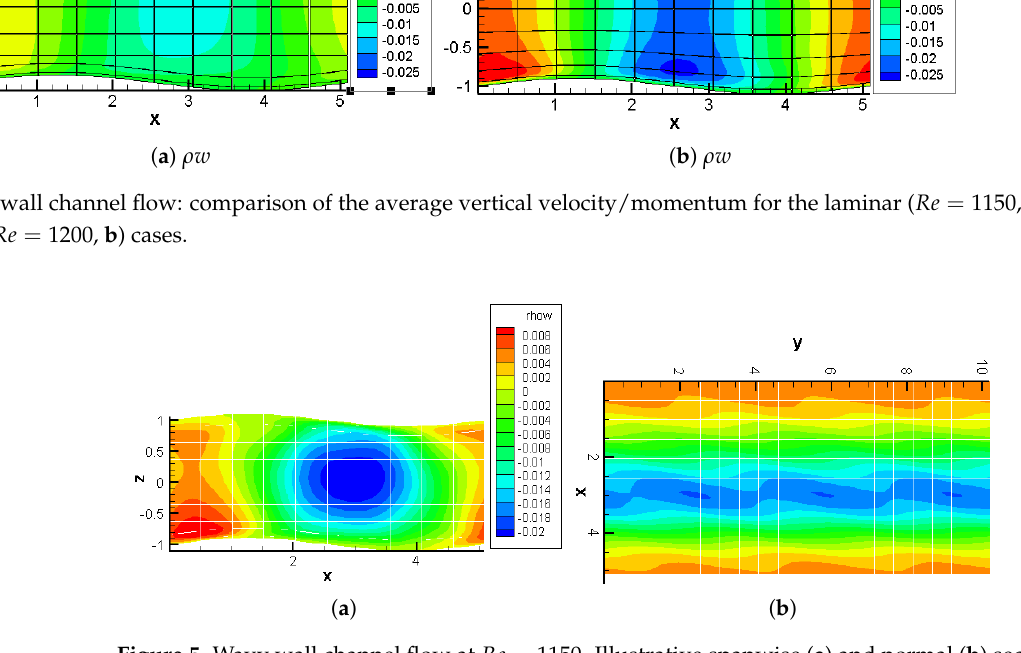
Figure 5. Wavy wall channel flow at Re = 1150. Illustrative spanwise ( a ) and normal ( b ) sections of the instantaneous vertical velocity